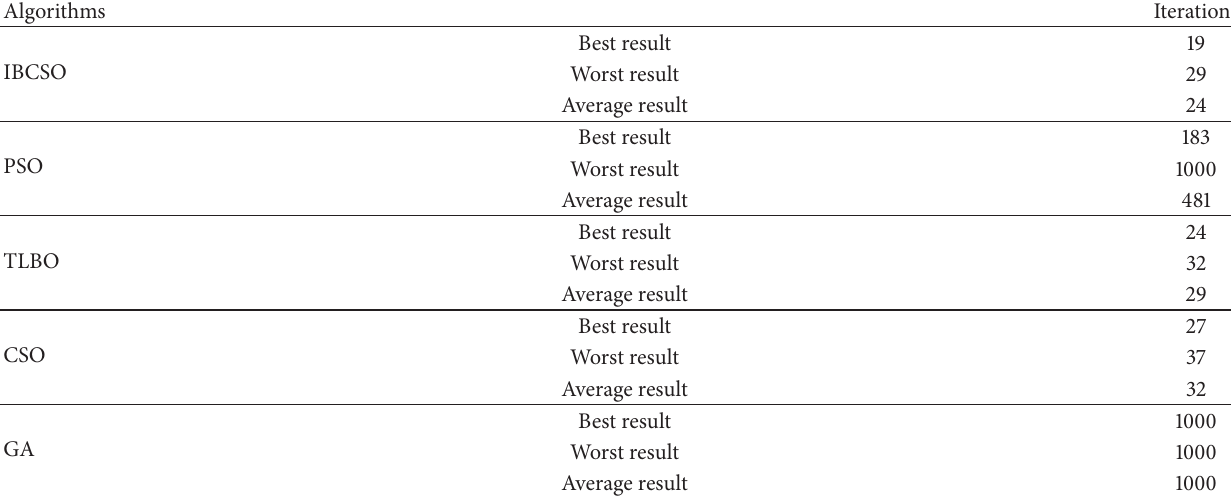
Table 3: Iterations required by IBCSO, CSO, PSO, GA, and TLBO.